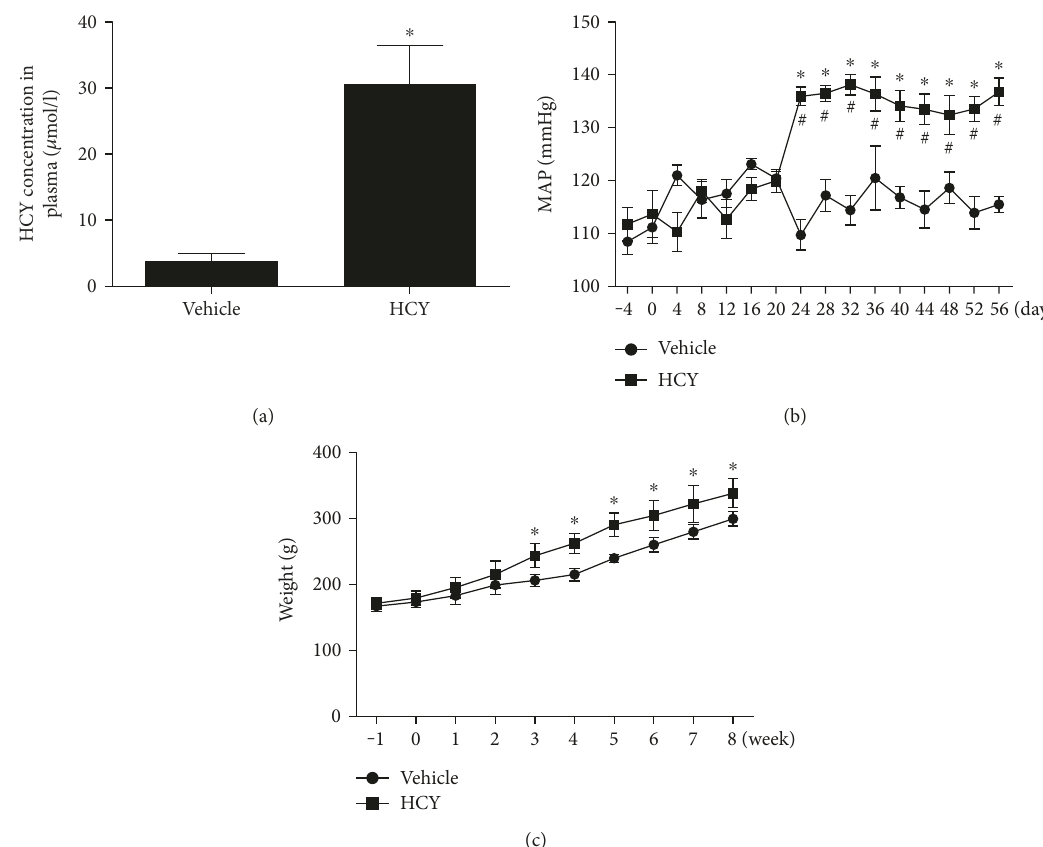
Figure 1: The concentration of HCY in plasma and changes in blood pressure and body weight in vehicle- and L-methionine-treated rats. Plasma HCY concentration (a), BP (b) obtained in conscious rats, and body weight (c) were signi fi cantly increased in the HCY group compared to the vehicle group. n = 5 /group. ∗ P < 0 05 versus the vehicle group, # P < 0 05 versus 0